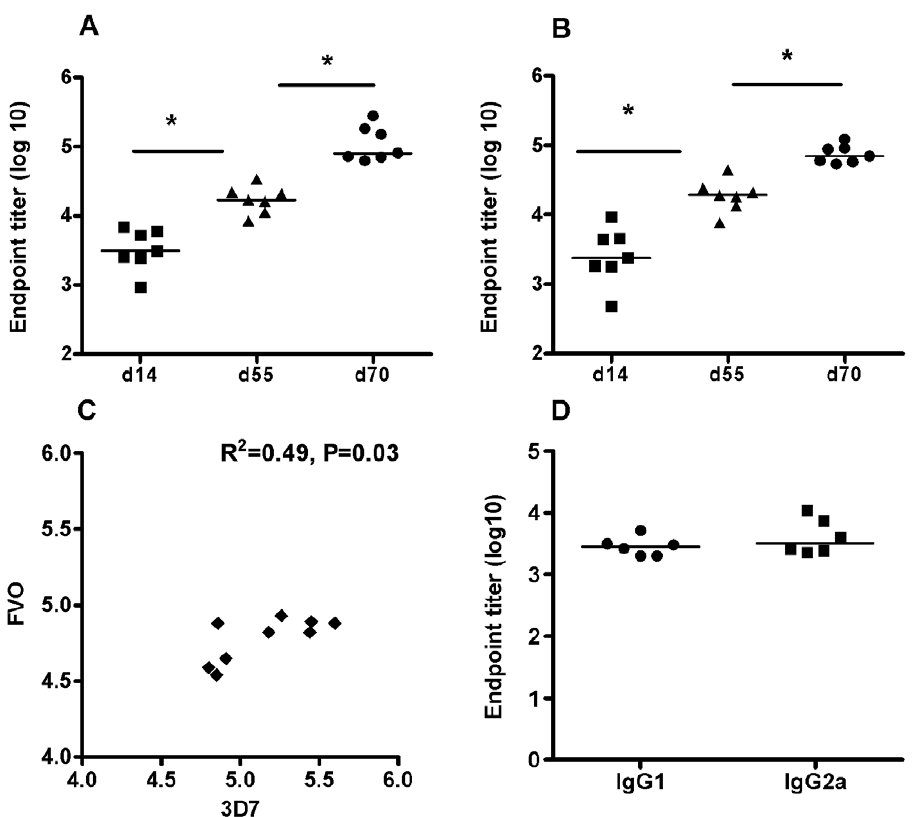
Figure 1. Murine antibody responses generated by AdHu5-MVA PfAMA1 (3D7) vaccination. 5–6 week old female BALB/c mice ( n =7/ group) were immunized via the intradermal route with 5 6 10 10 vp of AdHu5-PfAMA1 and boosted 8 weeks later with 1 6 10 7 pfu MVA-PfAMA1. The AMA1 specific antibody response against both homologous 3D7 (A) and heterologous FVO (B) PfAMA1 recombinant protein was measured in the serum at day 14 (post prime), 55 (pre boost) and 70 (post boost). Data show the responses from individual mice and the lines represent the median. The asterisk indicates a significant difference between the different time-points as analyzed by Wilcoxon signed rank test (* P # 0.05). (C) The correlation between the 3D7 and FVO antibodies at day 70 was analyzed using Pearson’s rank correlation (R 2 =0.49, P # 0.05). (D) IgG isotypes were assessed at day 70 in the serum against recombinant FVO PfAMA1.